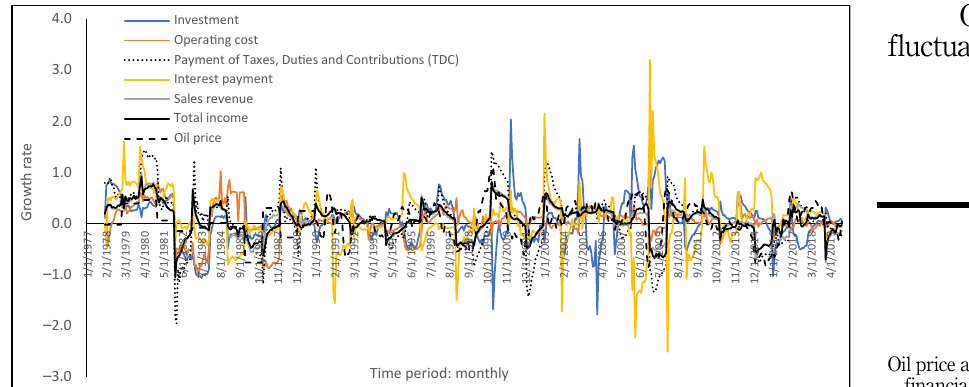
Figure 6. Oil price and Pemex ’ s